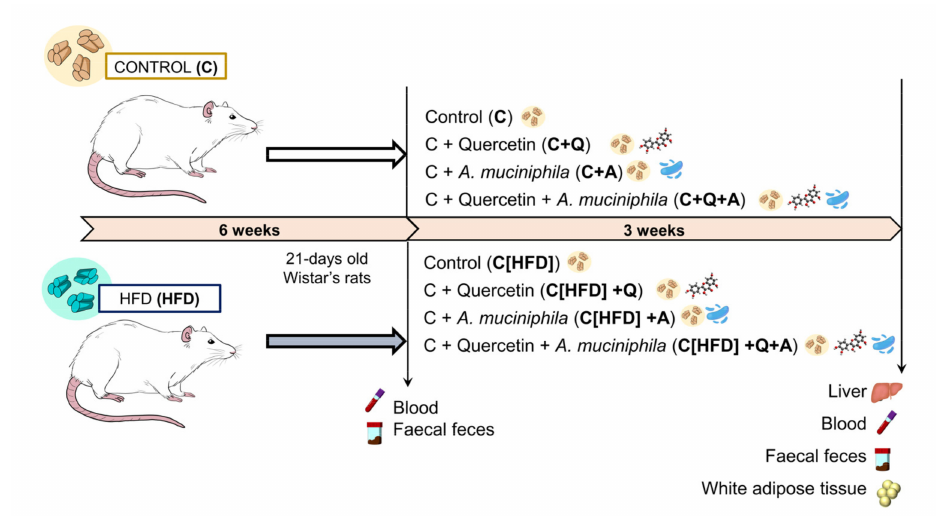
Figure 1. Experimental design. 21-day-old Wistar rats were fed with control or HFD for six weeks. Then, HFD-fed rats were allocated to control diet feeding and both groups (C and HFD) were split into four subgroups, based on diet intervention uniquely (C and Diet groups), quercetin supplementation (C+Q and C[HFD]+Q groups), Akkermansia muciniphila administration (C+A and C[HFD]+A groups) and combined quercetin supplementation and A. muciniphila administration (C+Q+A and C[HFD]+Q+A groups) for three